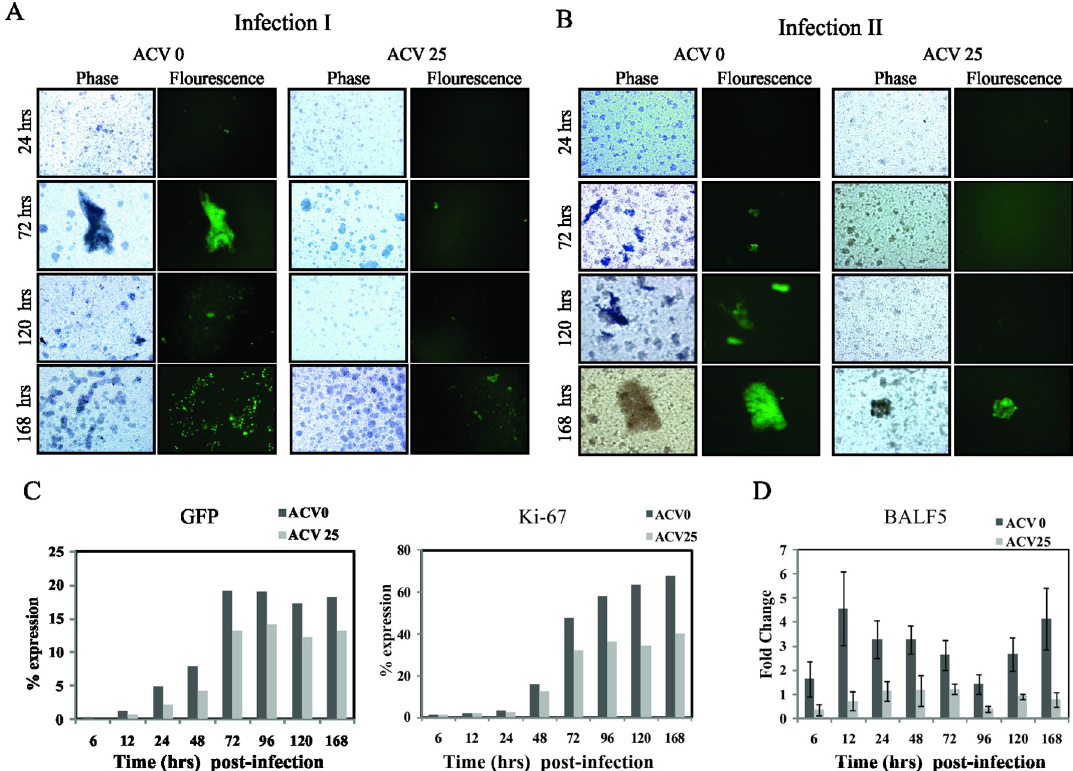
Fig 9. The progeny virus produced in the primary infection is inhibited by acyclovir. PBMCs were infected with GFP-EBV in presence and absence of 25 µ M of ACV (infection-I) and at specific times postinfection the supernatant was collected and used infect fresh PBMCs cells (infection II). (A) Phase-contrast (left) and fluorescence (right) images of GFP-EBV infected PBMC cells are shown after specific times postinfection (24 hrs, 72hrs, 120 hrs and 168 hours) in absence of ACV (left panel) and in presence of 25 µ M ACV (right panel). (B) Phase-contrast (left) and fluorescence (right) images of PBMC cells infected with supernatant from the above- mentioned times post-infection from 24hrs, 72hrs, 120hrs and 168h (infection-II) in absence (left panel) and presence of 25 µ M ACV (right panel). (C) Flow cytometry analysis of GFP (left panel) and Ki-67(right panel) expression at post-infection of different time intervals (6h, 12h, 24h, 48h, 72h, 96h, 120h and 168h) in absence and presence of 25 µ M ACV. (D) DNA polymerase BALF5 mRNA was also examined by qReal Time PCR after GFP-EBV infection at similiar intervals stated above in absence and presence of 25 µ M ACV. To determine quality of the RNA, GAPDH mRNA was also amplified by RT-PCR. The fold change was calculated by the ΔΔ Ct method. Each data point shown is the average of three identical experiments. ± SD was shown in error bar.